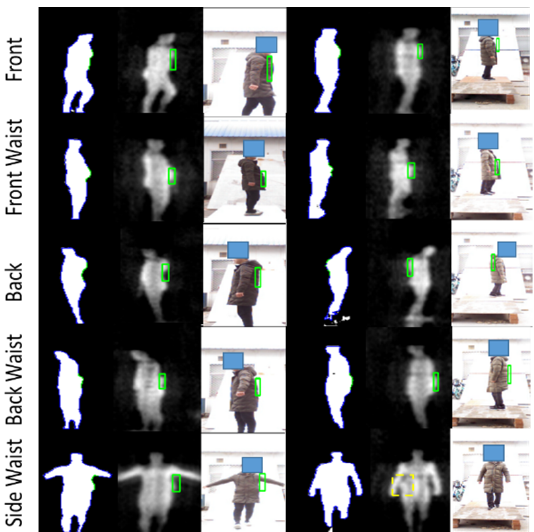
Figure 18. Visualized non-metallic threat detection of five different carrying positions. The first and